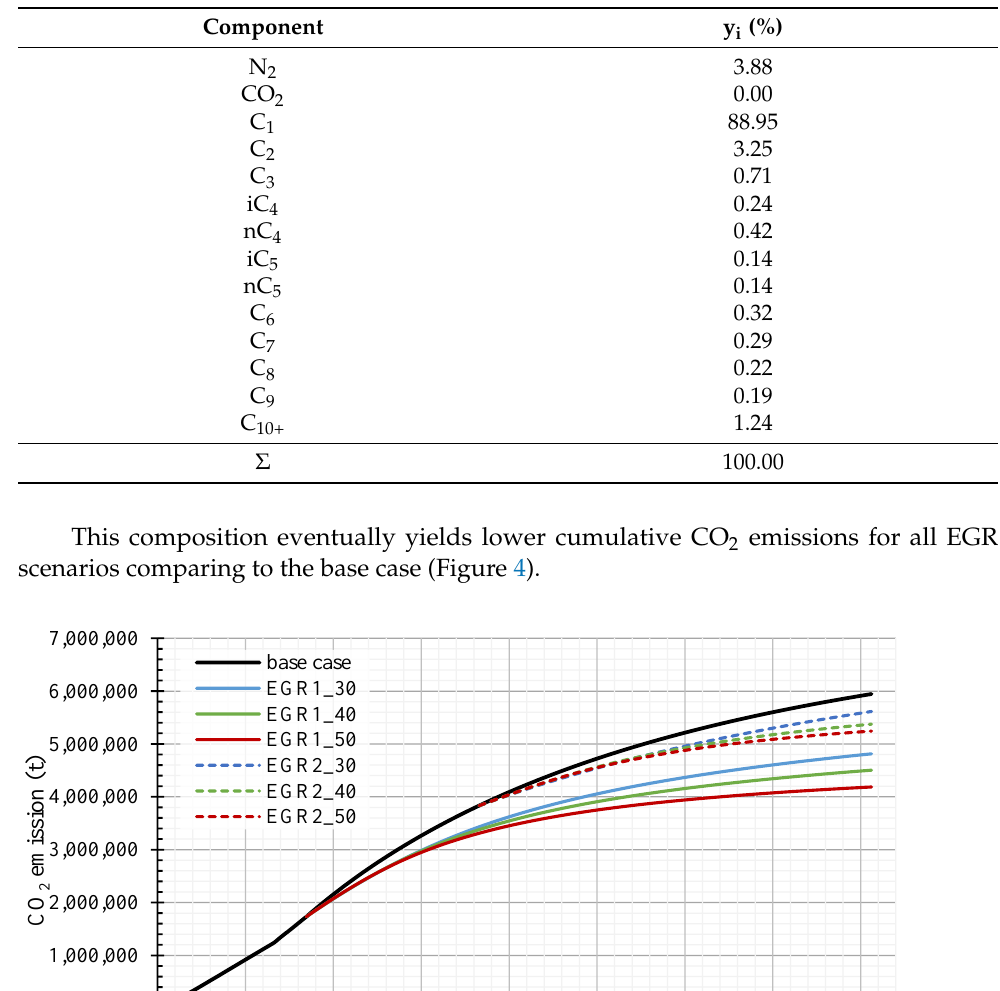
Figure 5. Difference between the produced and injected CO 2.